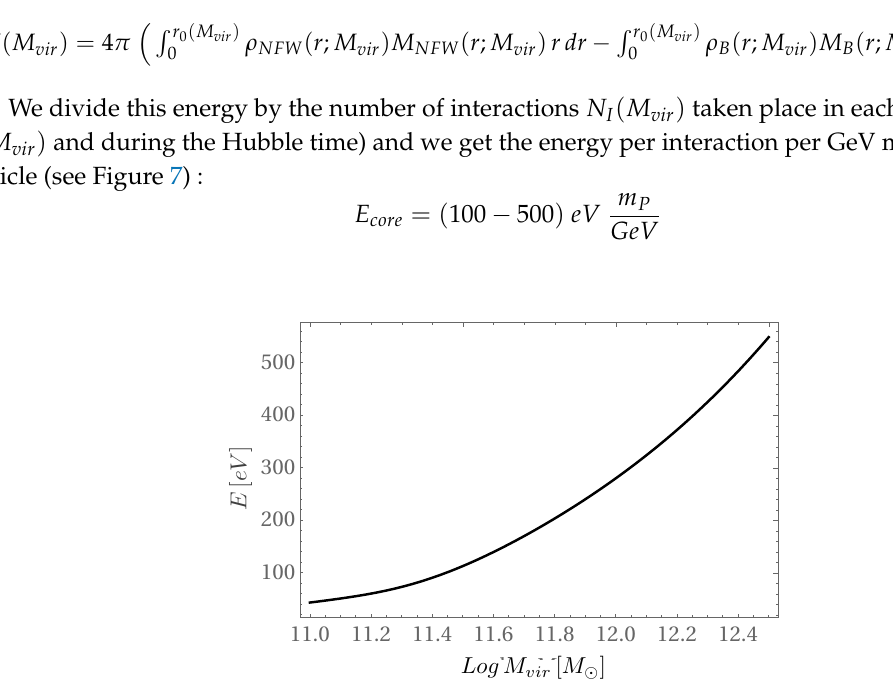
Figure 7. The energy of a core-forming SM–DM particles interaction for a GeV of the particle mass as a function of log M vir